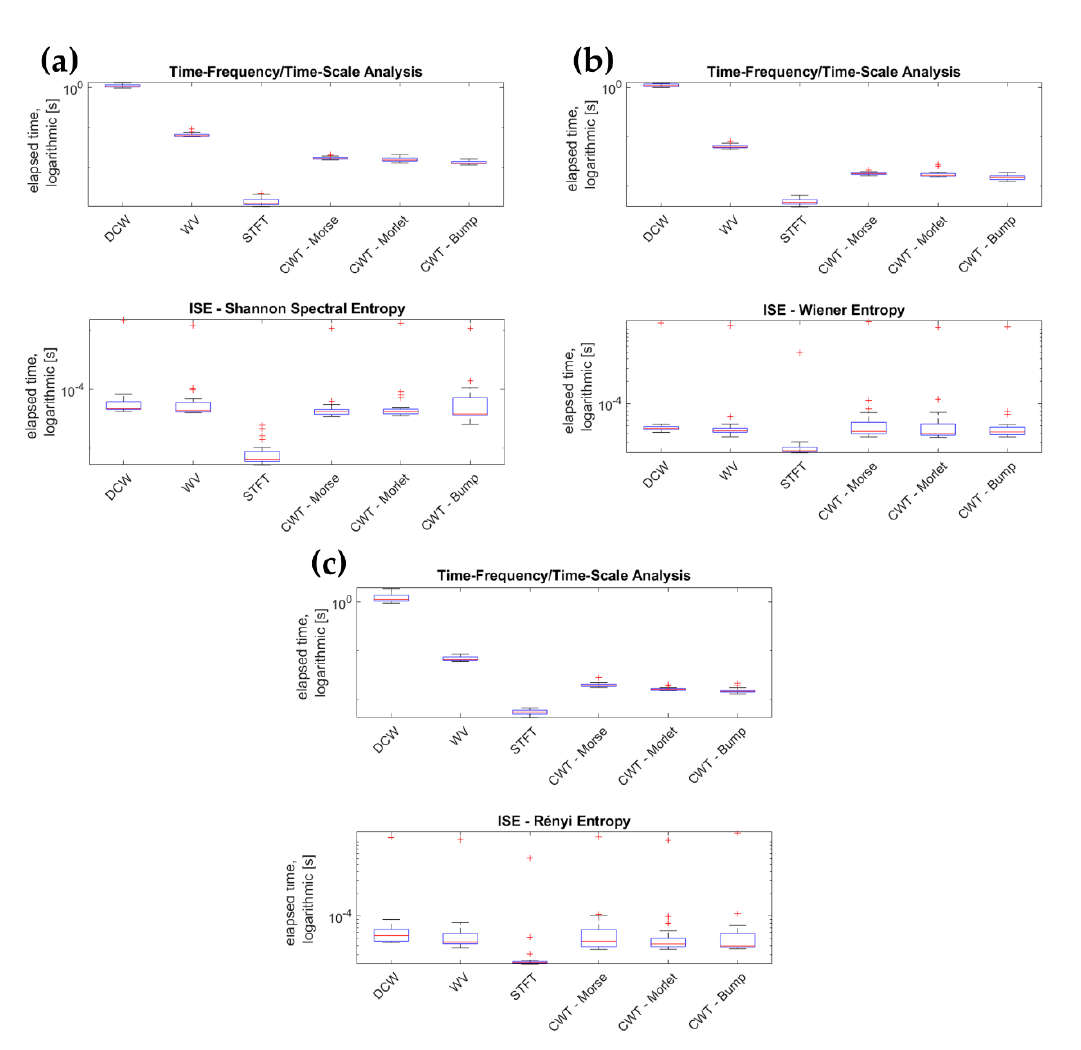
Figure 12. Breakdown of the elapsed time: ( a ) Shannon spectral entropy (SSE); ( b ) Wiener entropy (WE); ( c ) Rényi entropy of order 2 (RE2).